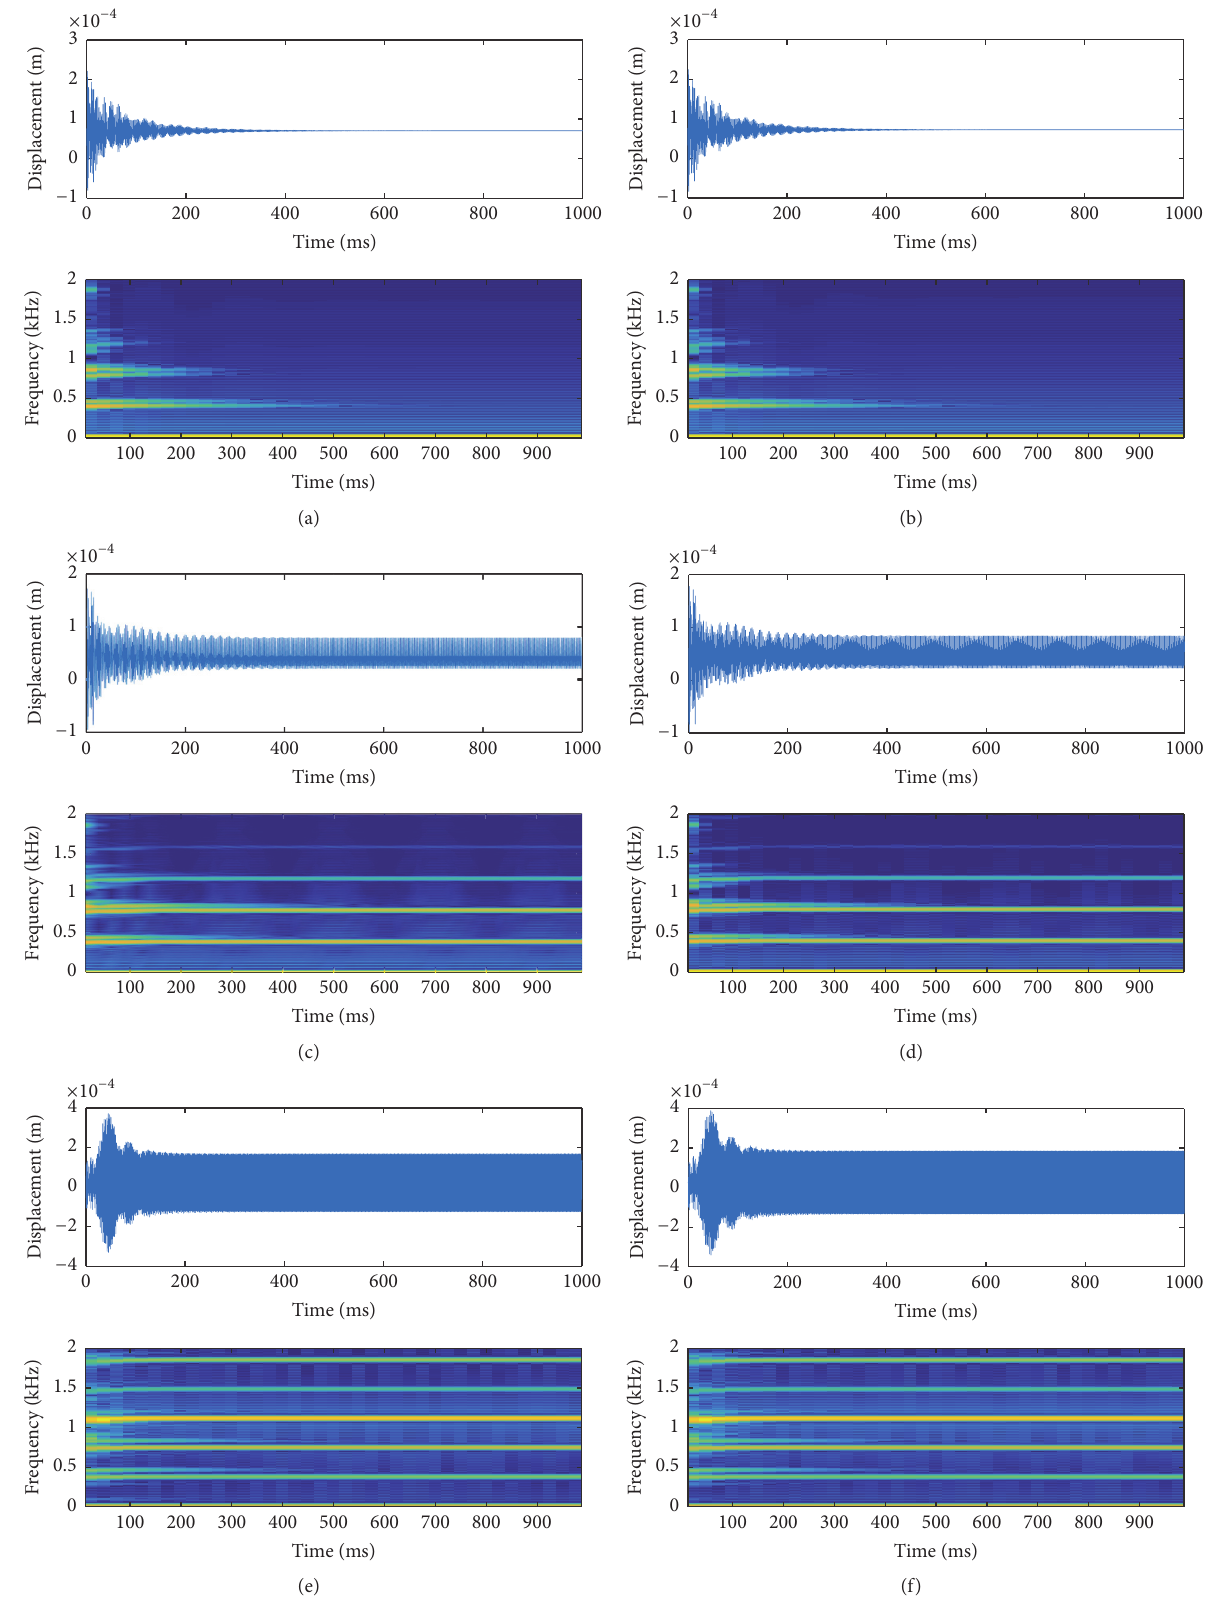
Figure 4: Transient simulations and spectrograms for one degree-of-freedom of the disc at the tangential component: (a, b) 𝜇 = 0.4 , (c, d) 𝜇 = 0.5 , (e, f) 𝜇 = 0.6 , (a, c, e) reference, and (b, d, f) reduced model with 15 interface